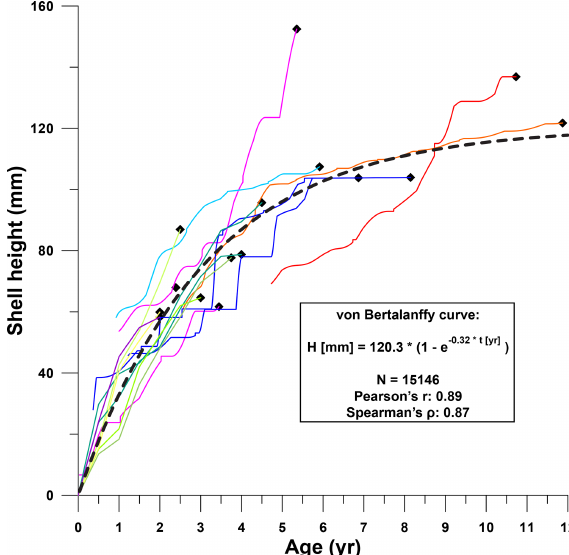
Figure 10. Shell height plotted against age for all R. diluvianum records (see Fig. 8 for color legend of lines representing individ- uals). The similarity between growth curves of different specimens allows a von Bertalanffy curve to be fitted to the data with high con- fidence. Sinusoidal patterns superimposed on all growth curves are caused by seasonal variability in growth rate (see Figs. 6–7). Data found in Fig. S9 from de Winter et al.